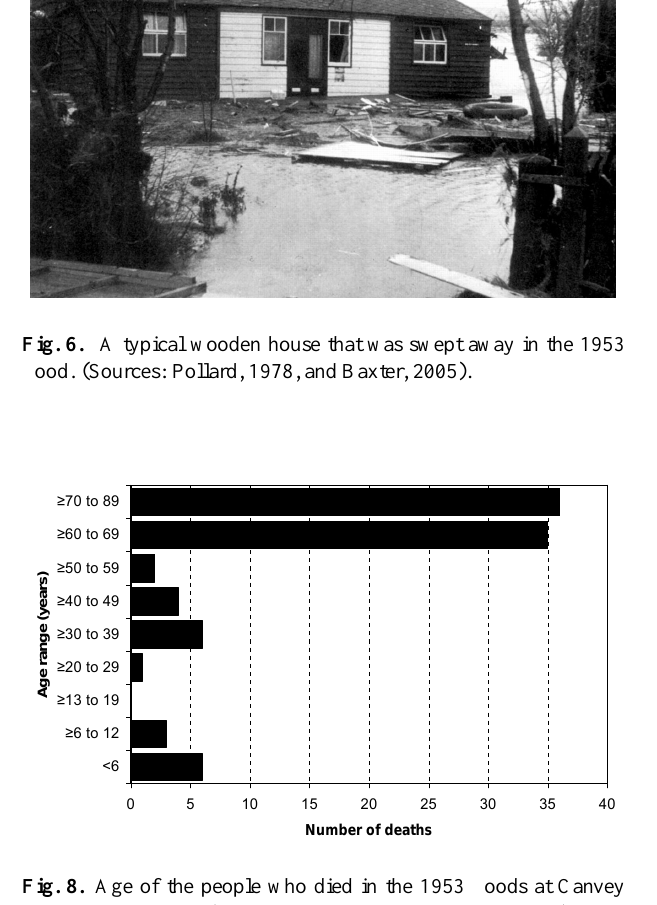
Fig. 9. Age and sex of the people who died in the 2010 coastal floods caused by Xynthia. (Source: Based on data collated by Université Paul-Valéry Montpellier III, 2010).